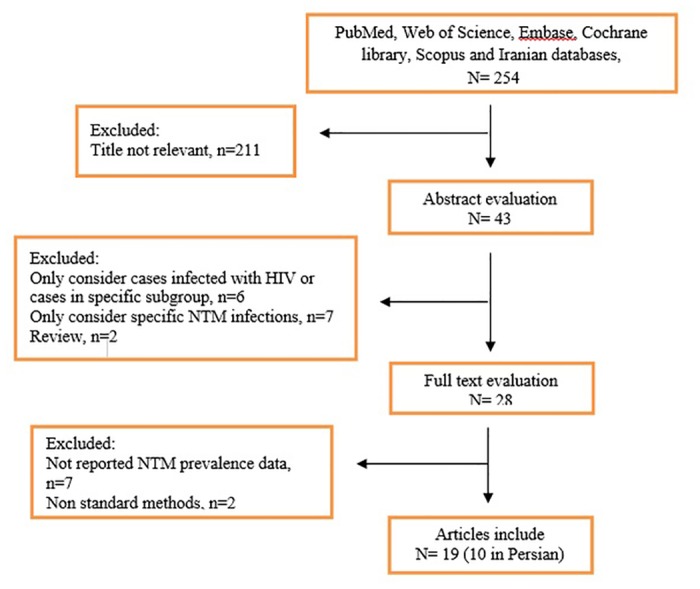
Flow diagram of literature search and study selection.